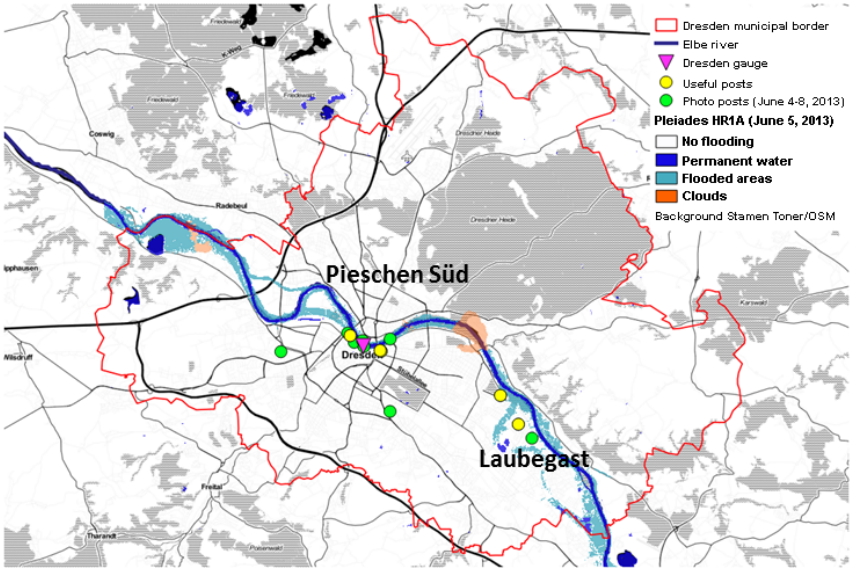
Figure 3. Study region and data sources for flood inundation depth